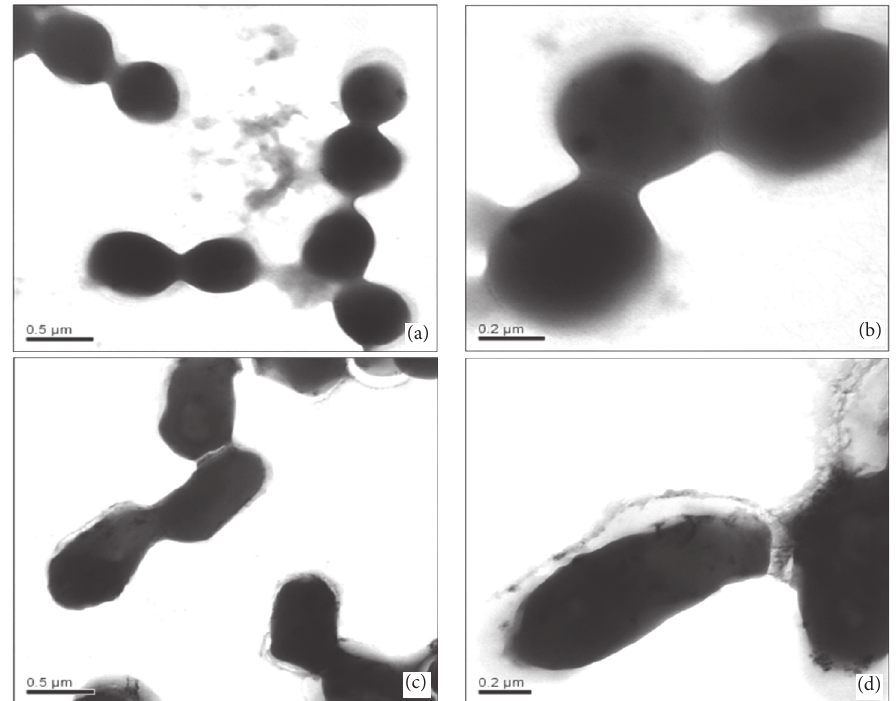
Figure 6: TEM images of S. aureus (a, b) and E. coli (c, d) after 12 h treatment with ZnO-3. (a) and (c) were in view of low magnification, while (b) and (d) were in view of high